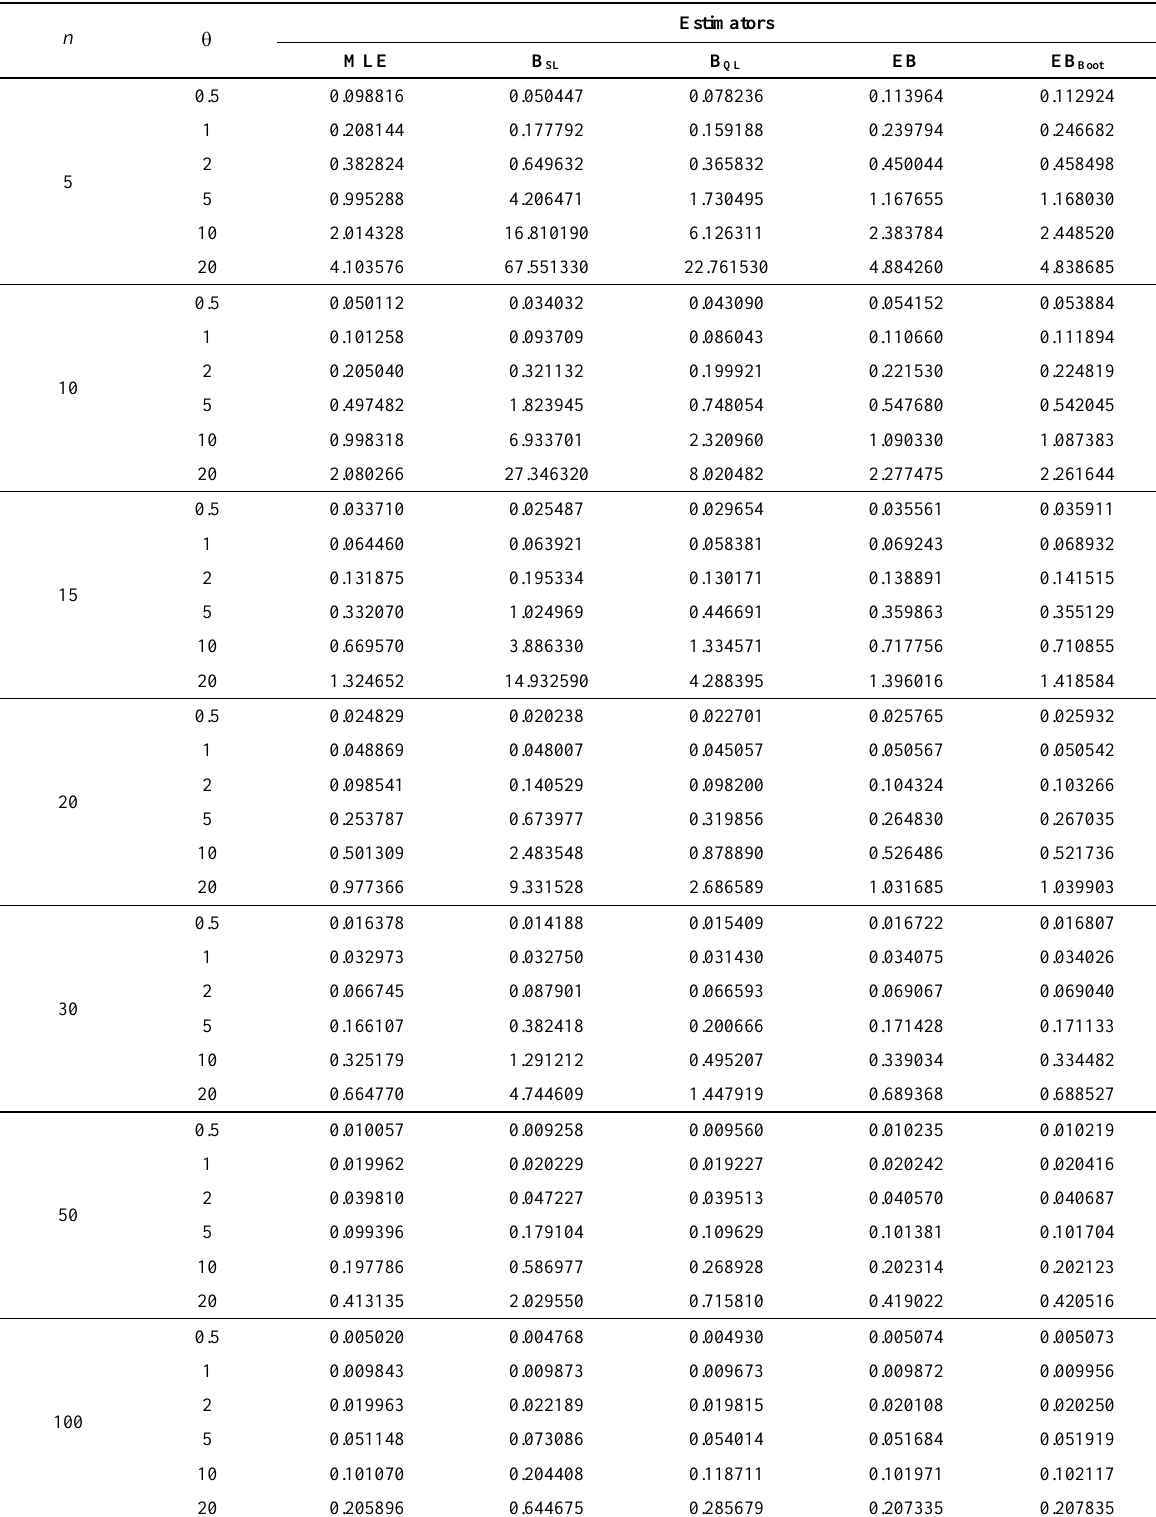
Table 3. MSE of different estimators of Poisson distribution when a=1,